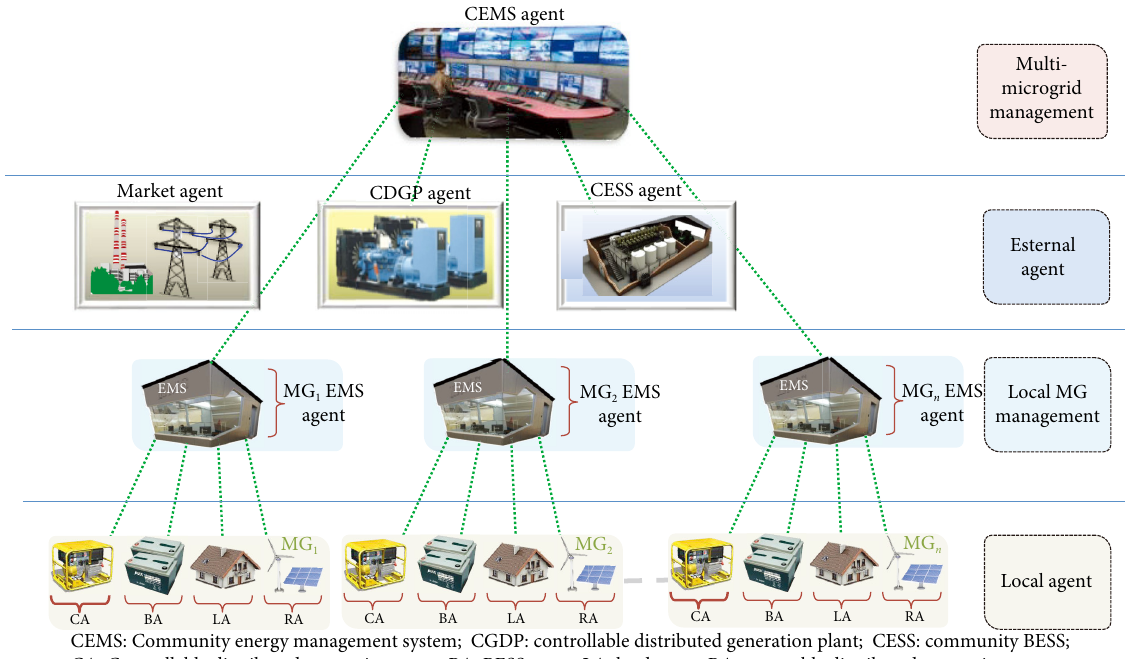
Fig. 7 Configuration of the MAS management for multi-microgrids [39]